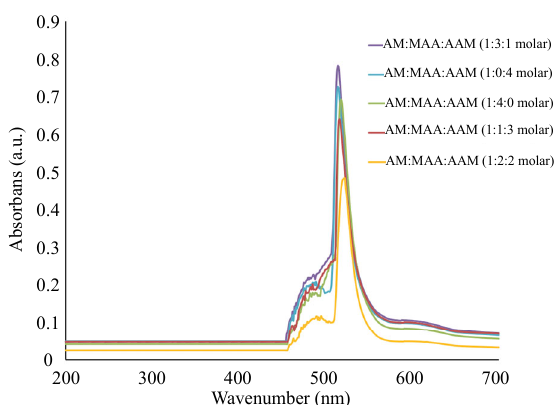
Fig. 1 UV spectrum measurements of AM:MAA:AAM pre-polymerization complexes prepared at different molar